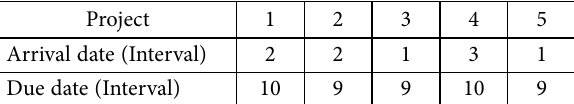
Table 3. The confirmed projects arrival dates